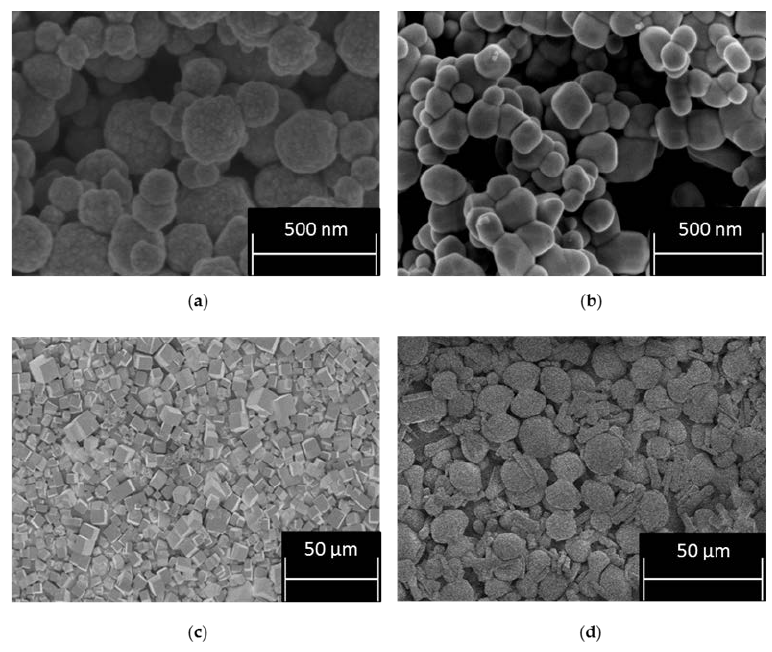
Figure 1. Scanning electron micrograph of: ( a ) caesium phosphomolybdate (CPM) formed at 50 °C; ( b ) titanium dioxide (TiO 2 ); ( c ) zirconium molybdate (ZM-a); and ( d ) zirconium molybdate (ZM-b).